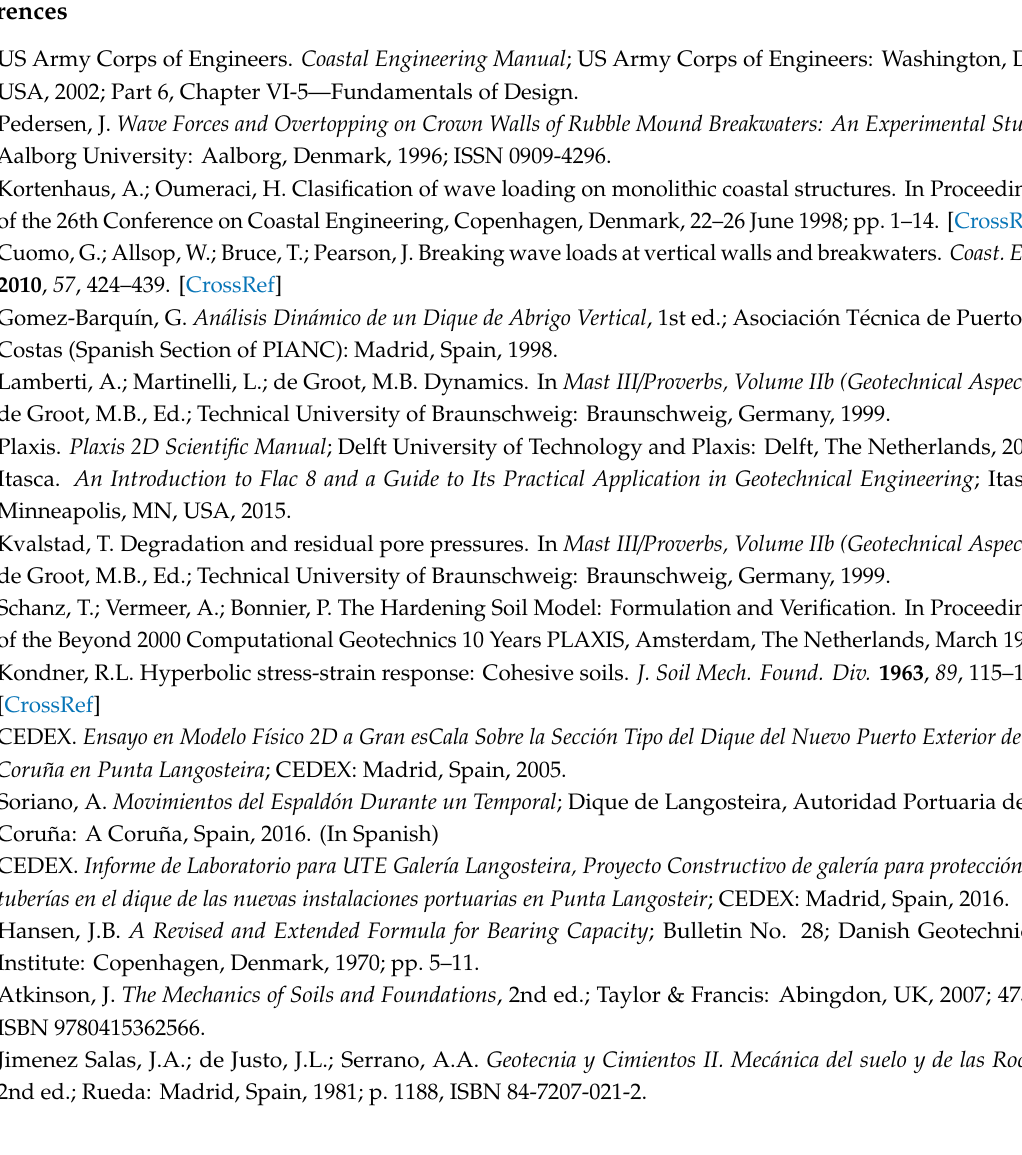
Figure A8. Process of hardening and softening produced by deformation, adapted from Atkinson [14].